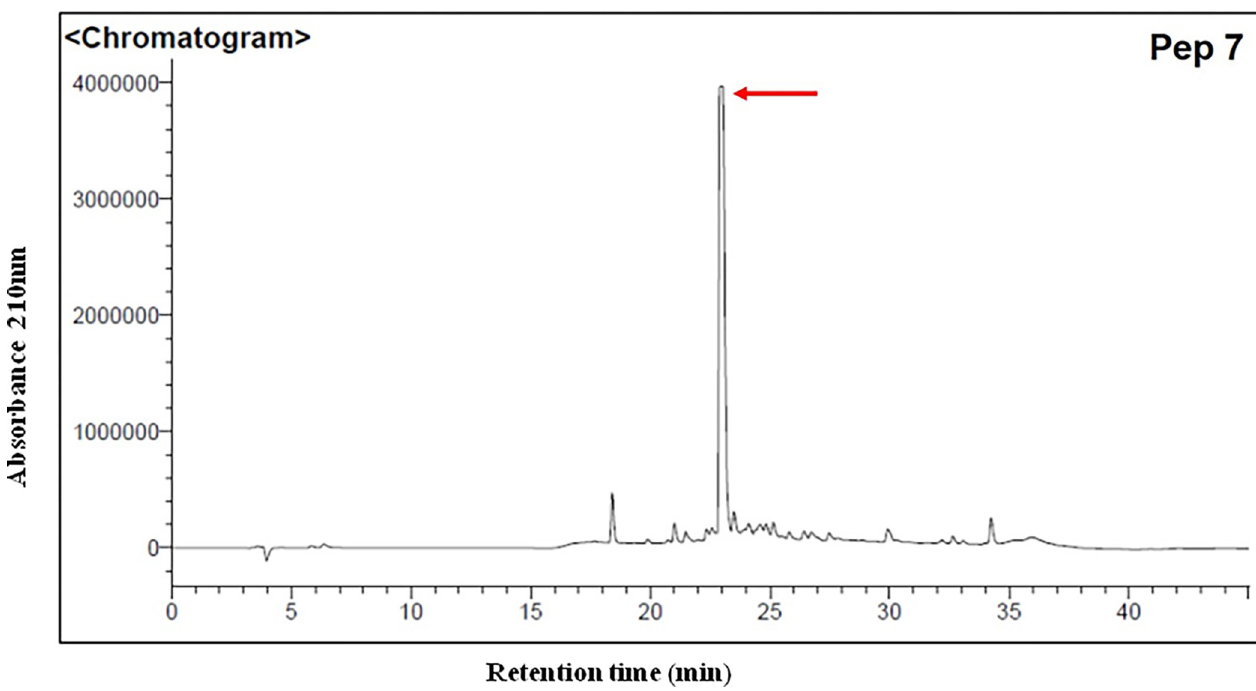
Fig 2. HPLC chromatogram representing the peak of peptide 7 after purification as